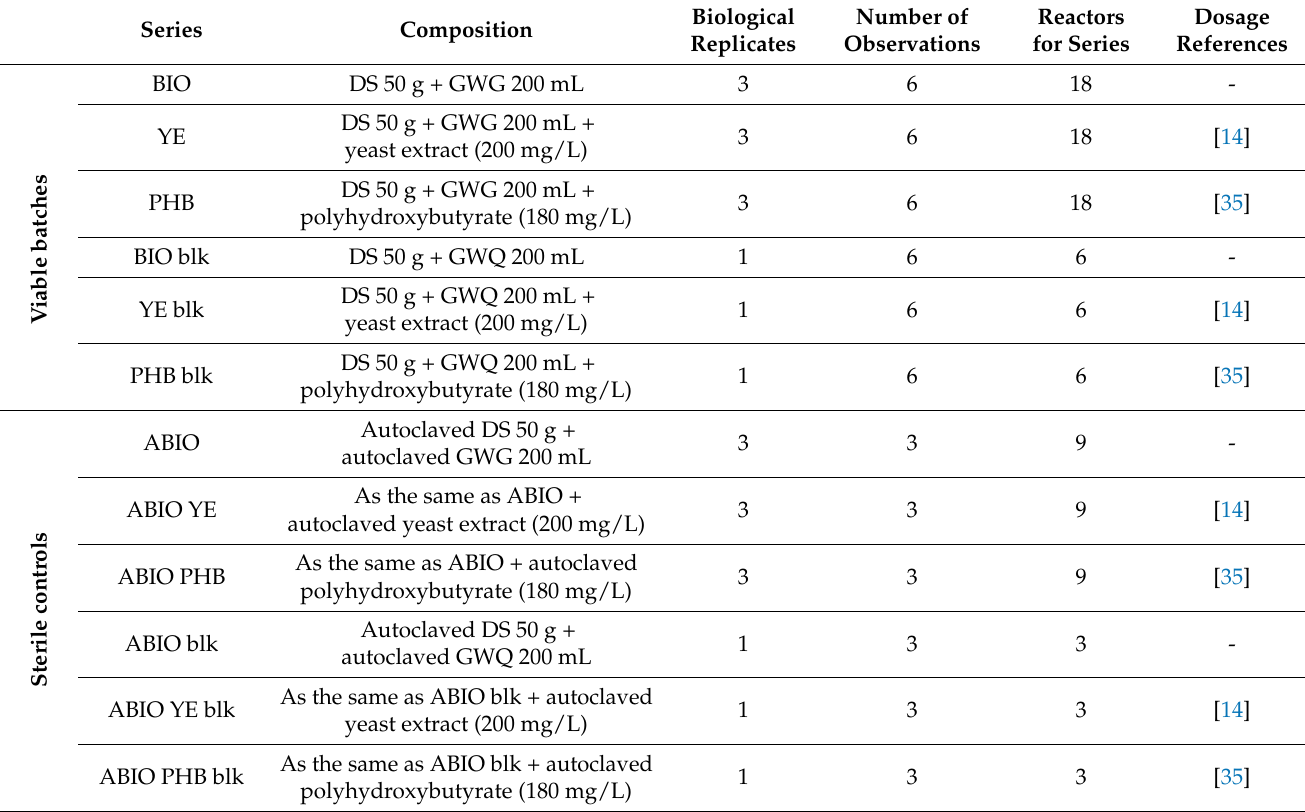
Table 1. Microcosms series composition and the related number of reactors set up in this